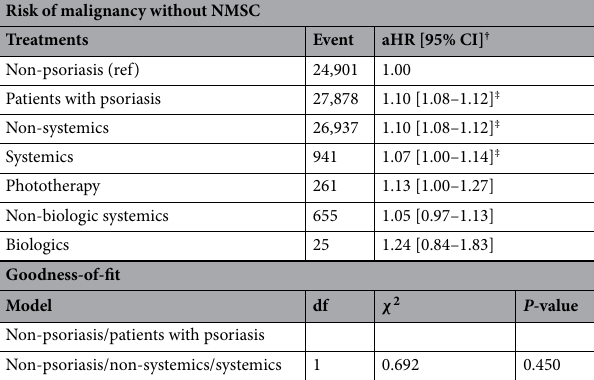
Table 3 summarizes the cumulative dosages of anti-psoriatic treatments among patients who experienced malignancy without NMSC. Mean (SD) cumulative dosages were 44.1 (46.7) for phototherapy, 4970.7 (5649.2) mg for acitretin, 35054.7 (50603.5) mg for cyclo- sporin, 471.5 (709.1) mg for methotrexate, 1154.3 (861.8) mg for adalimumab, 5765.0 (4688.1) mg for etaner-